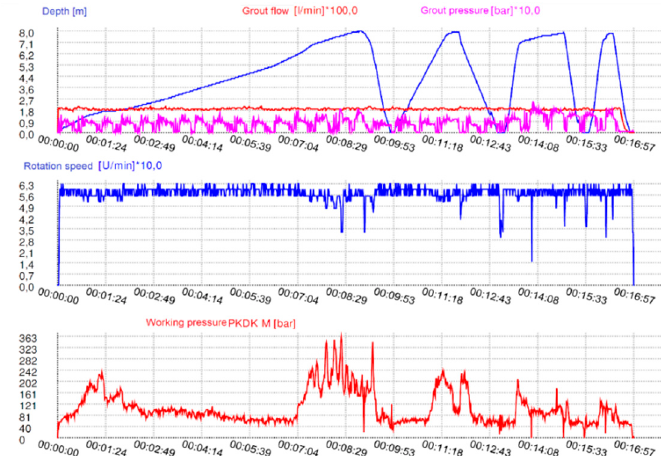
Figure 10. Parameters registered by the device during the formation of the 456 representative columns.